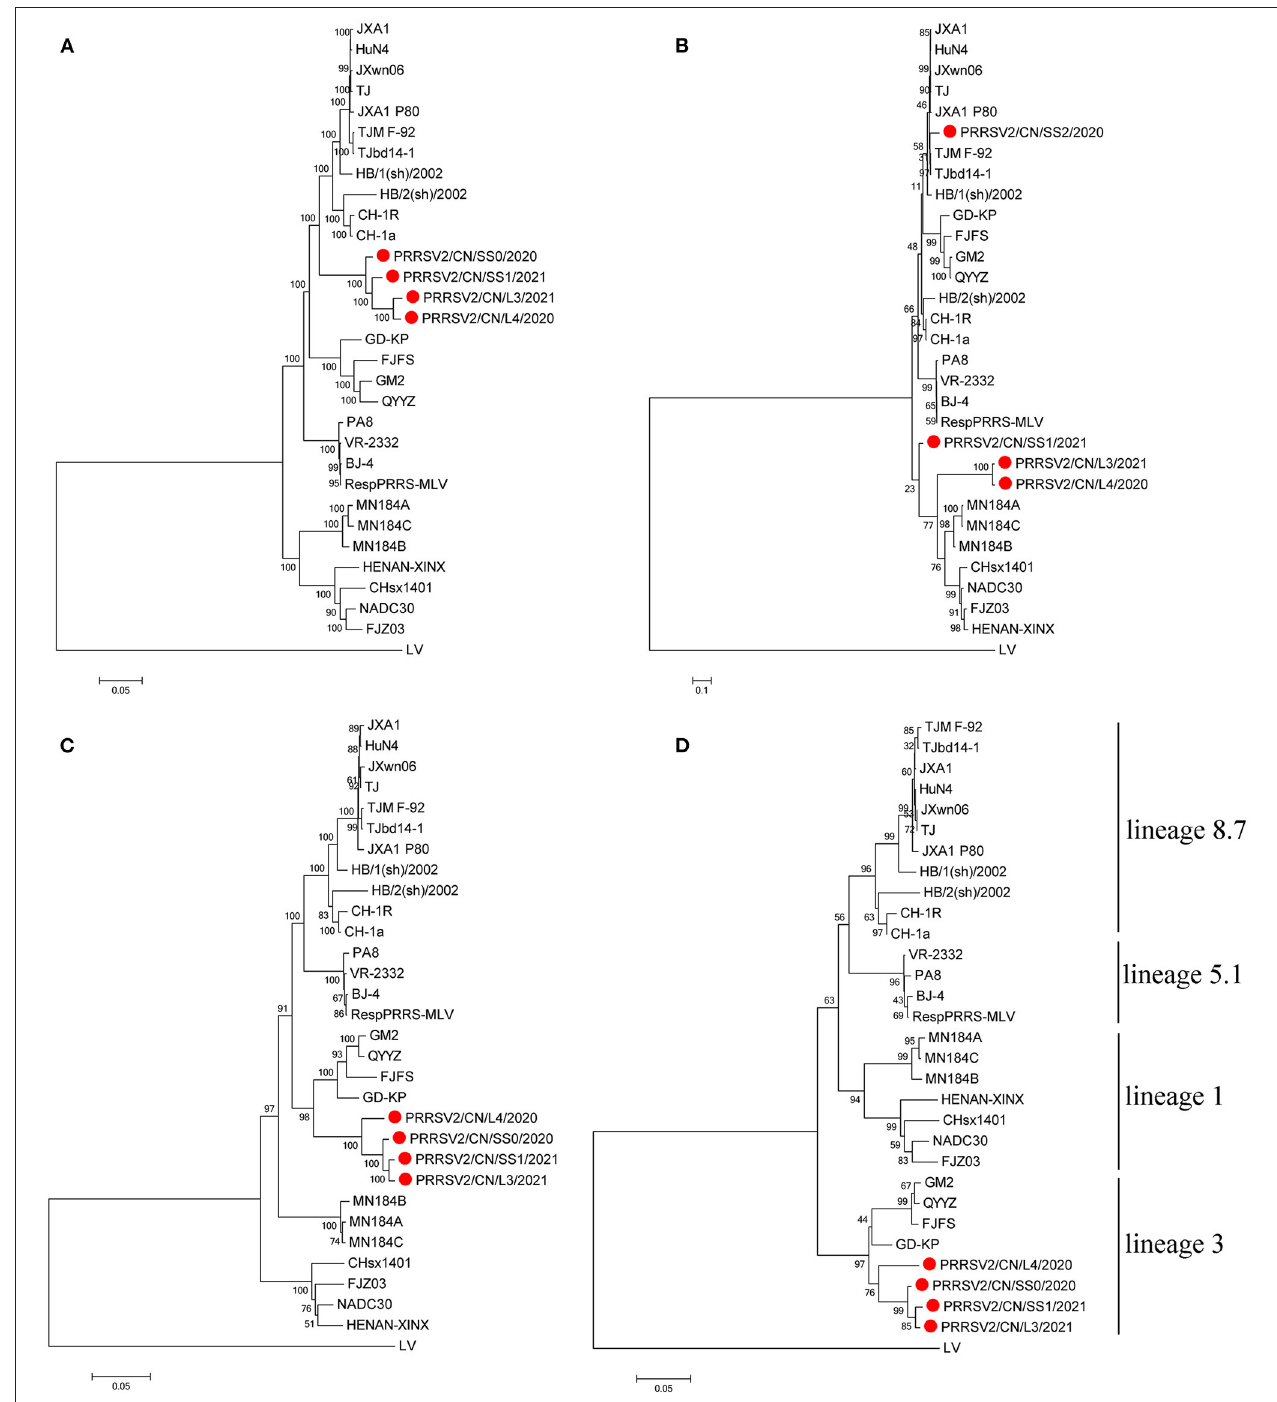
FIGURE 1 | Phylogenetic tree based on the full length (A) , Nsp2 (B) , ORF2-7 (C) , and ORF5 (D) of the four PRRSV strains from this study and reference strains. The four PRRSV strains isolated in this study are labeled with a red circle. The reliability of the tree was evaluated by bootstrapping using Mega 7.0 with 1000 replicates.